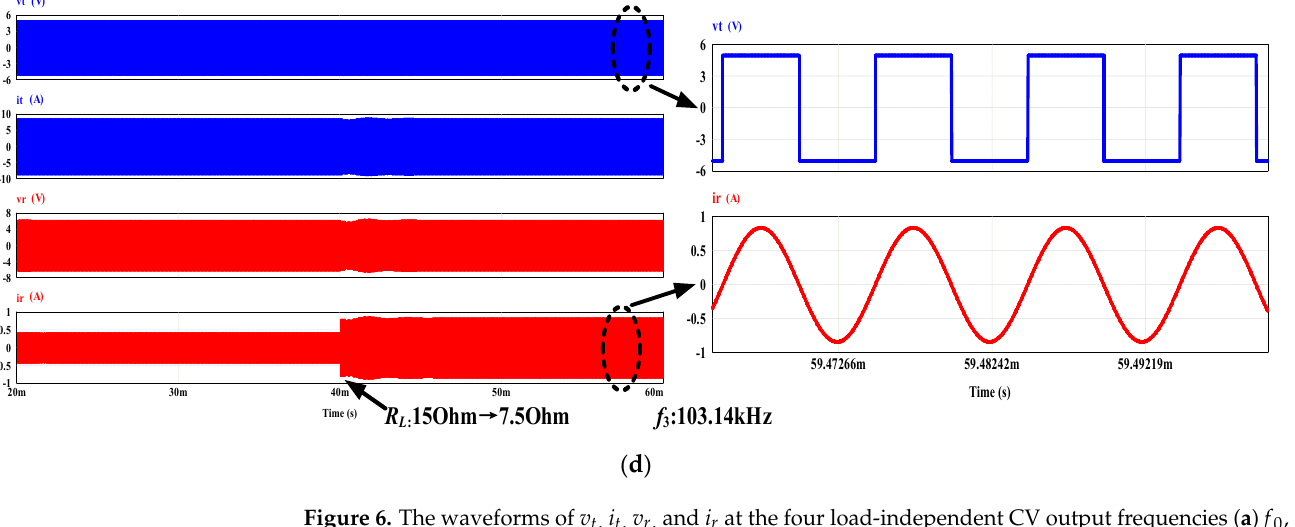
Figure 8. Photograph of the experimental setup. Table 2. Main parameters of the proposed domino WPT system. Symbol